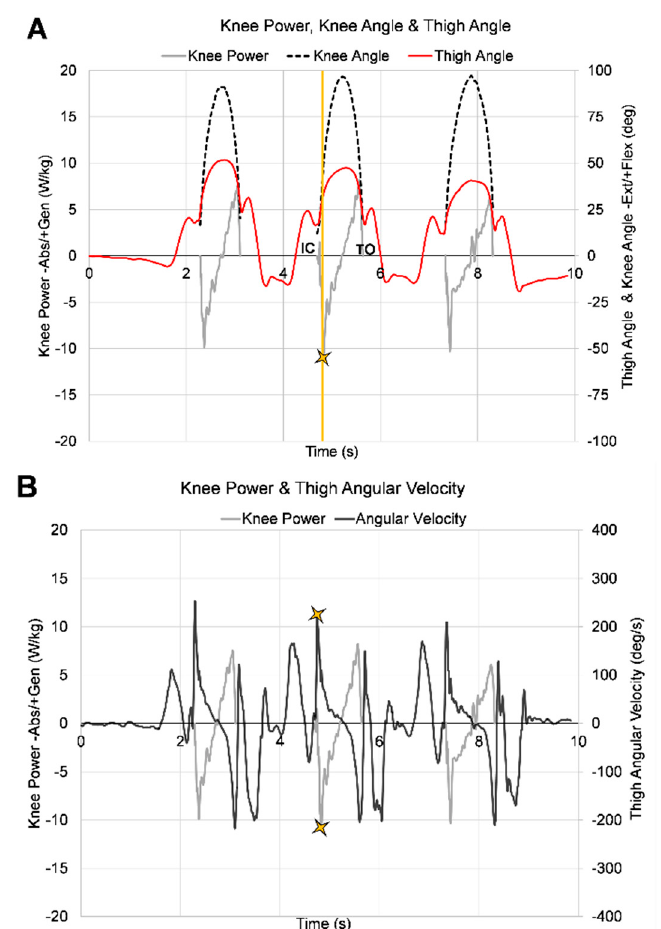
Figure 3. Three cycles of single limb loading task performed by one representative subject. ( A ) Marker-based knee angle (dashed black line), knee power (gray line), and inertial sensor thigh angle (red line); ( B ) Marker-based knee power (gray line) and inertial sensor thigh angular velocity (black line). Stars indicate the peak knee power absorption ( A ) and peak thigh angular velocity ( B ) identified after initial contact and before maximum knee flexion during the middle repetition of one trial.